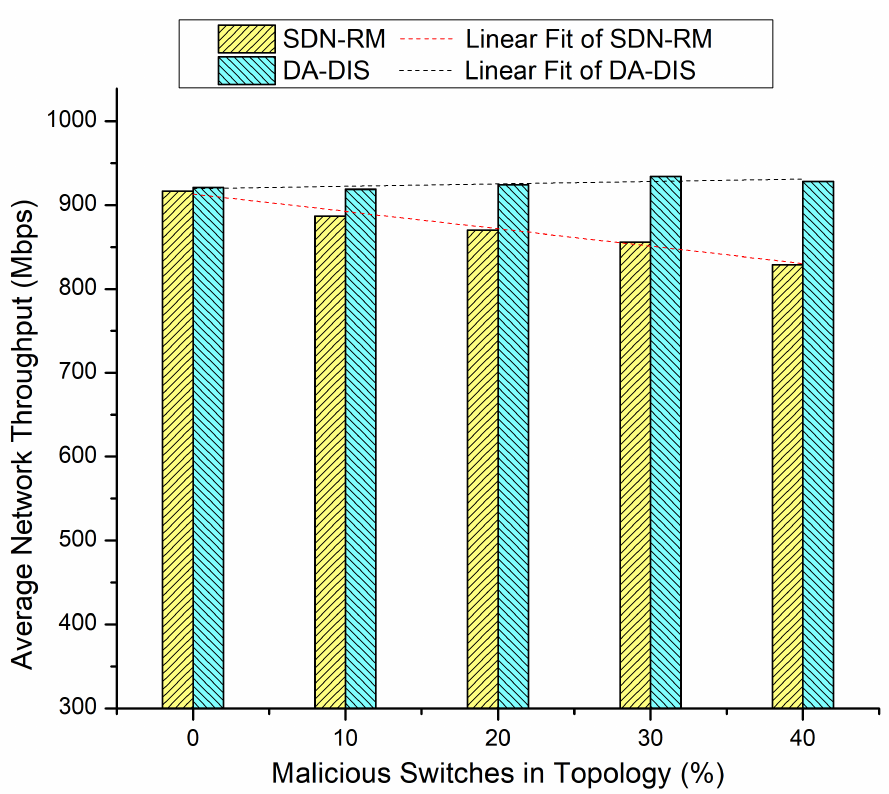
Figure 10. Throughput considering different numbers of malicious switches with E1 category faults. Table 1. Result overview of Case